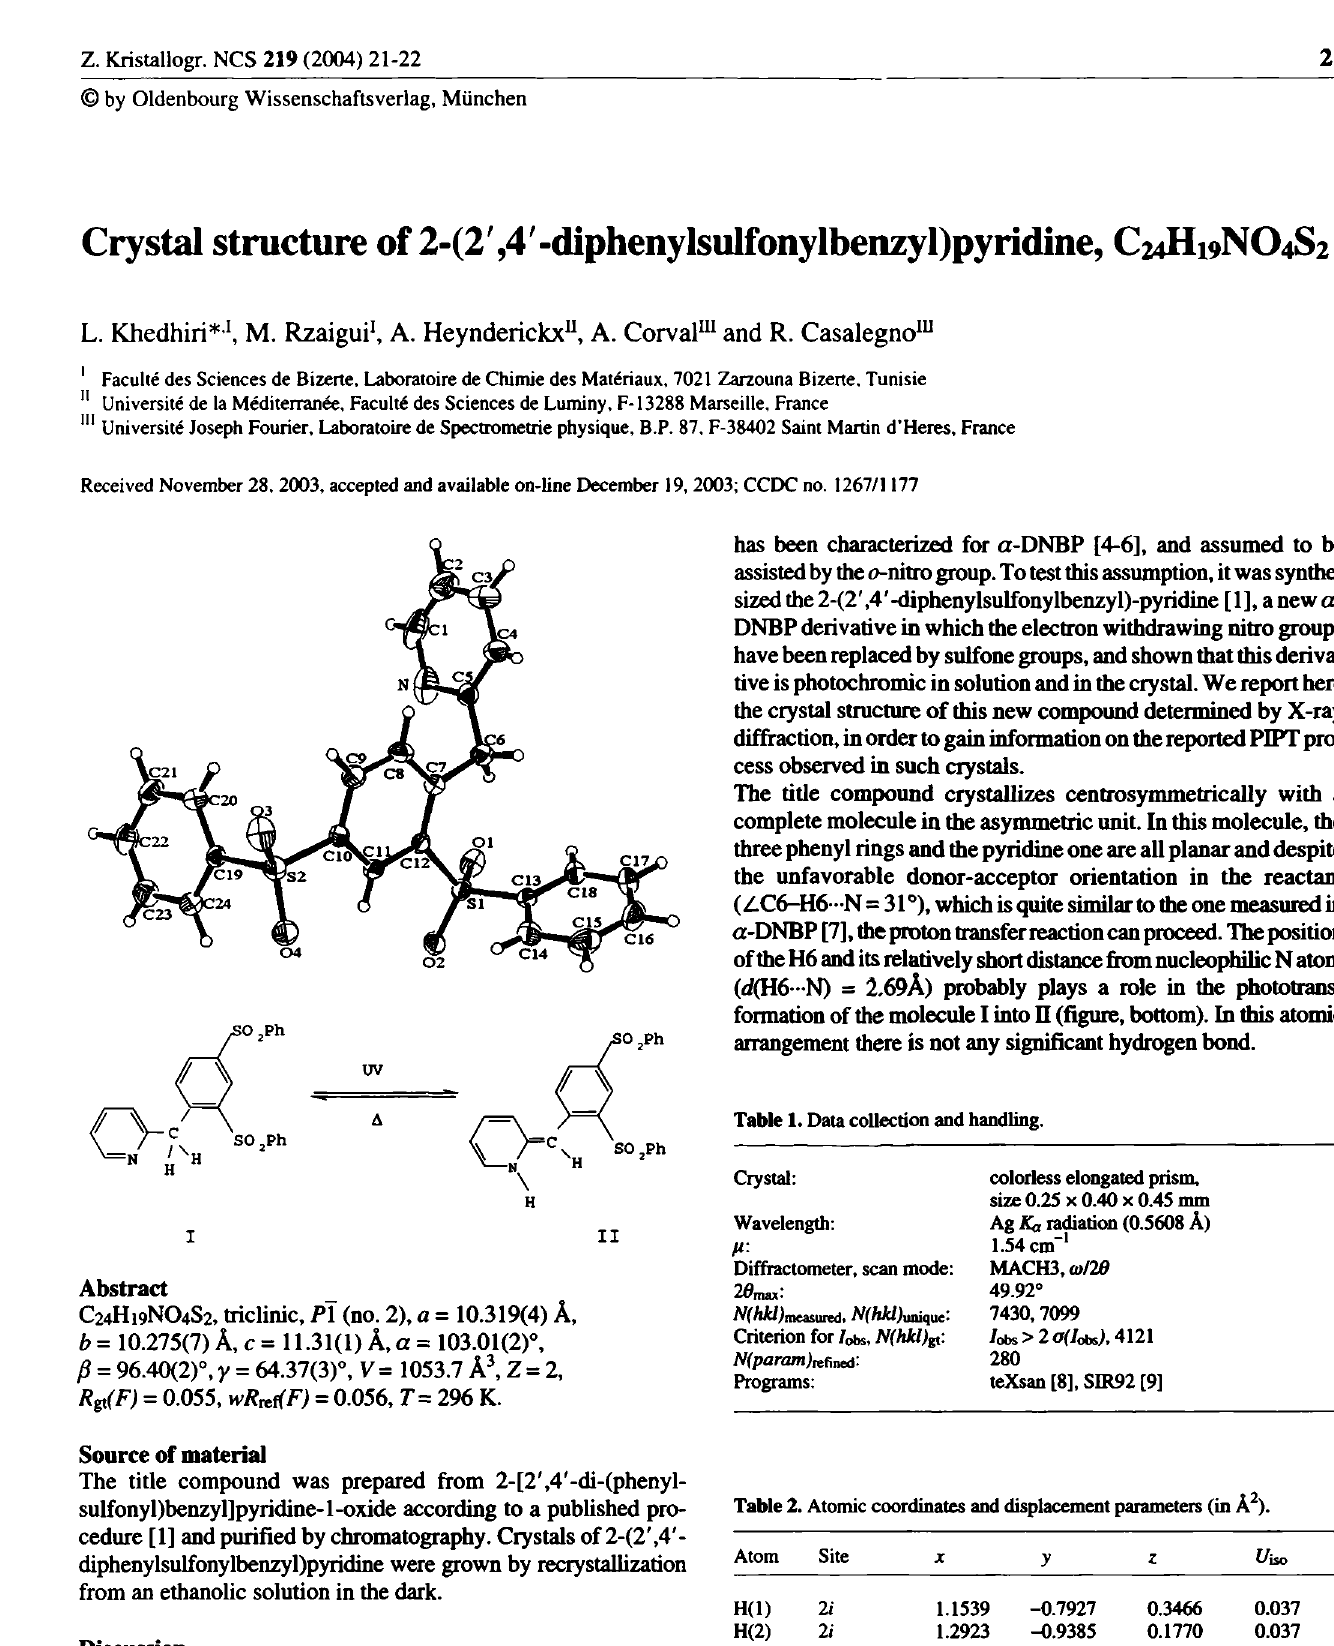
Table 2. Atomic coordinates and displacement parameters (in Â 2